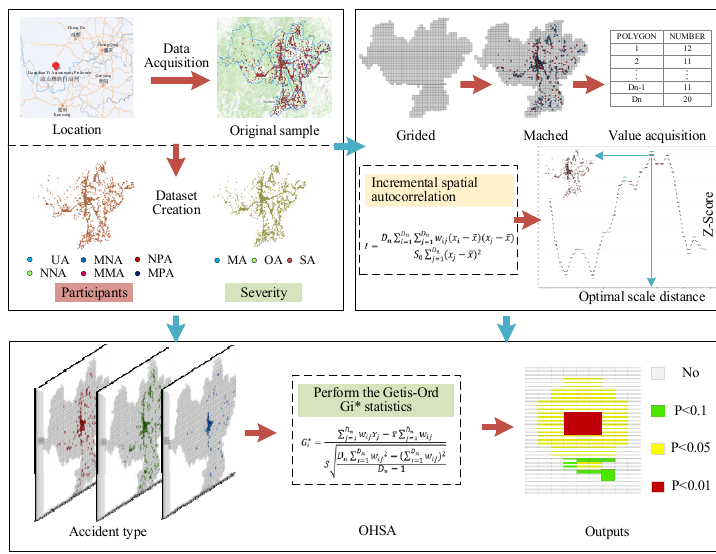
Figure 1. The flowchart of the proposed method.